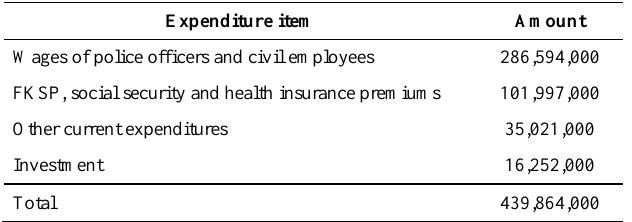
Table 3. PCR expenditures in connection with the Vrbětice emergency in 2014–2019